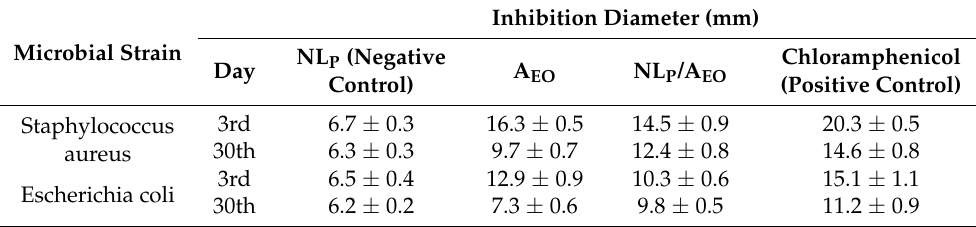
Table 4. Antibacterial activity (growth inhibition zone based on mm) of NL P , A EO, and NL P /A EO .